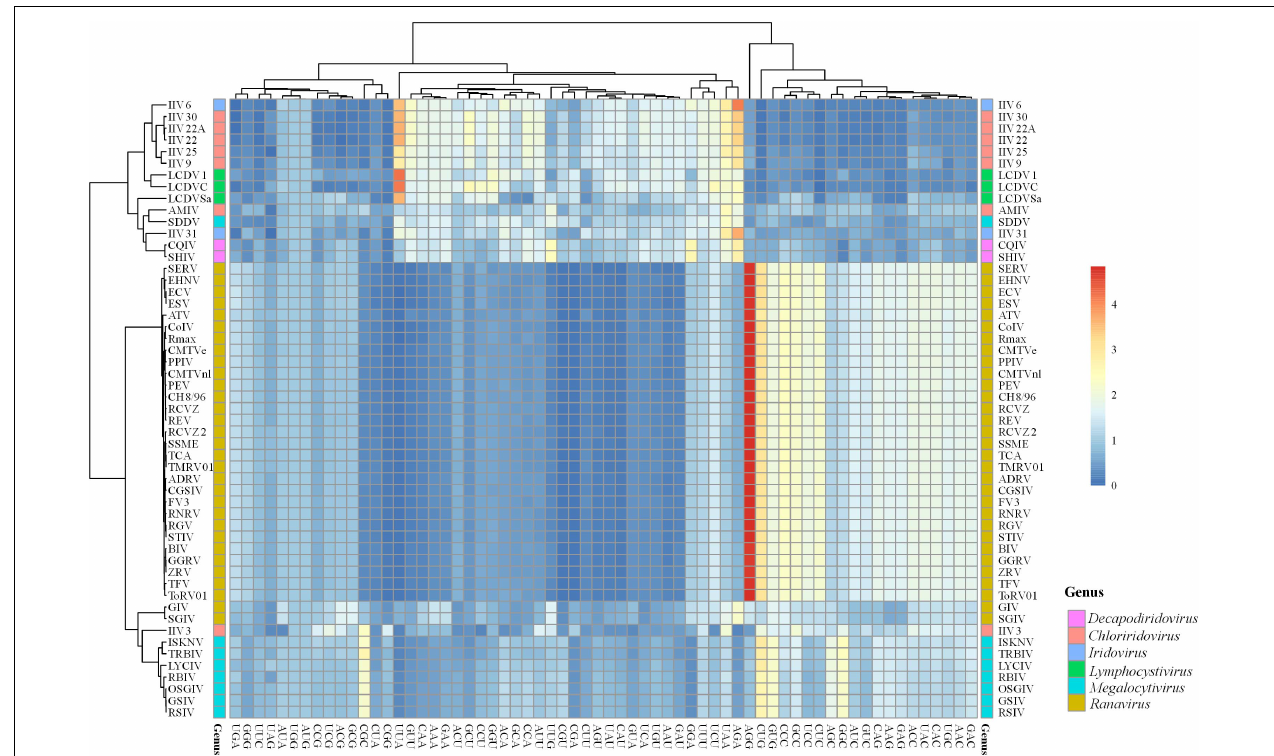
FIGURE 3 | Heat map of RSCU values of 53 iridovirids. Each column represents a codon and each row represents a different virus species.